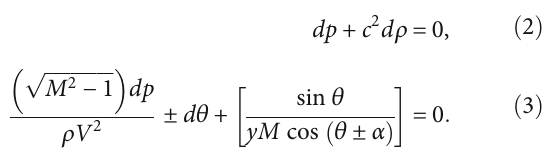
ffiffiffiffiffiffiffiffiffiffiffiffiffiffi p (cid:3) M 2 − 1